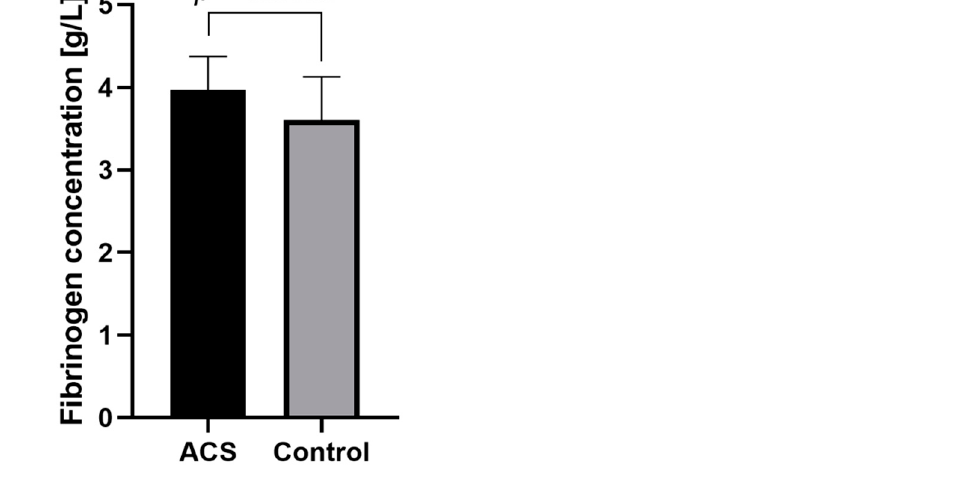
Figure 4. The comparison of plasma fibrinogen levels in ACS and control groups. Data presented in the graph show the mean concentration ± SD. Obtained results passed the Shapiro–Wilk’s test, and the unpaired Student’s t -test was used to calculate the differences.